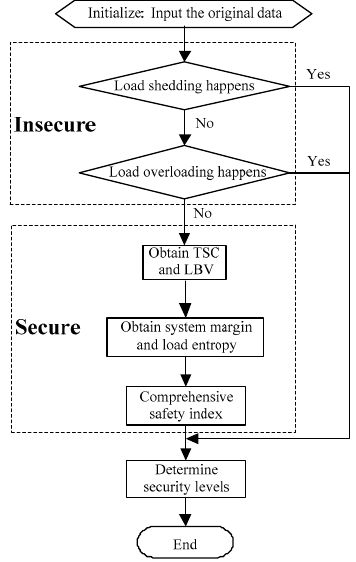
Figure 1. Flowchart of security level classification of power systems.